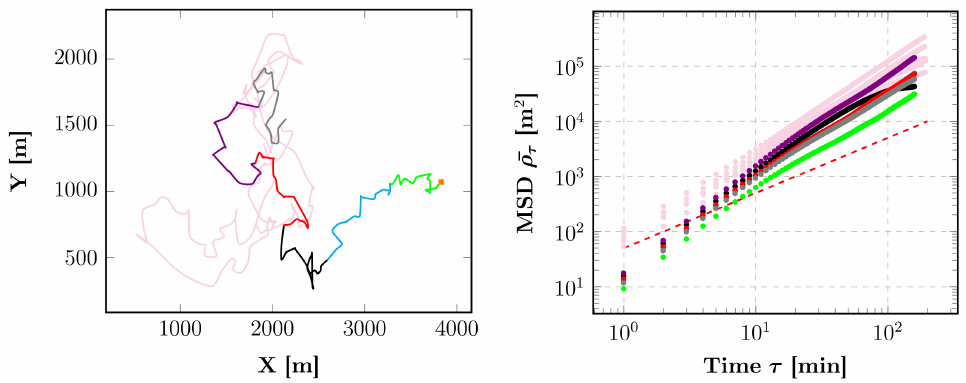
Figure 11. Evolution of the group position ( left ) with the corresponding MSDs ( right , mean α = 1.53 ± 0.08) for a simulation of 6 consecutive days during high food availability in the dry evergreen forest, with control parameters abundanceReach = 0.1, explorationZone = 2, velocity = 1 and levyRatio = 35. Pink trajectories and MSDs represent the troop data. The orange square indicates the departure of the group of particles and the dashed line represents a line of a unitary slope, i.e., for α =